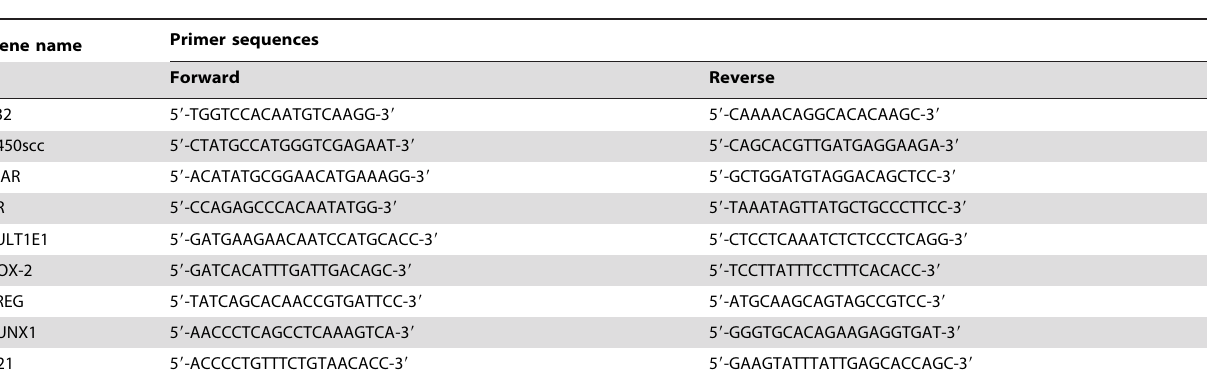
Table 1. Primer sequences for Real-time PCR.